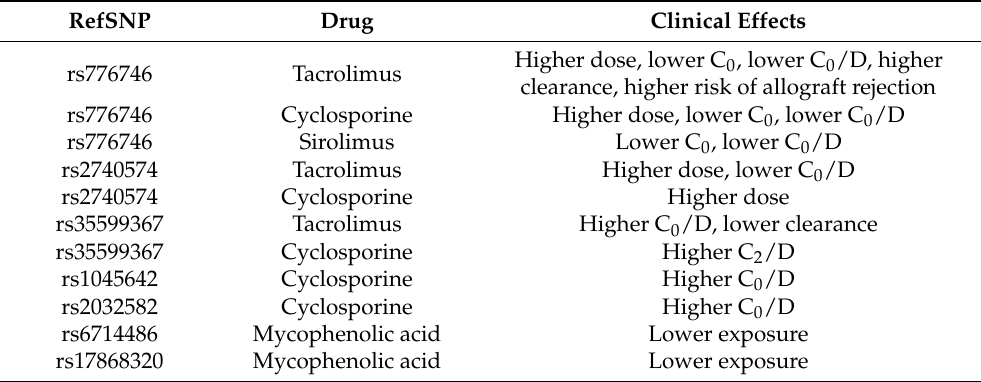
Table 2. Summary of SNPs’ effects on